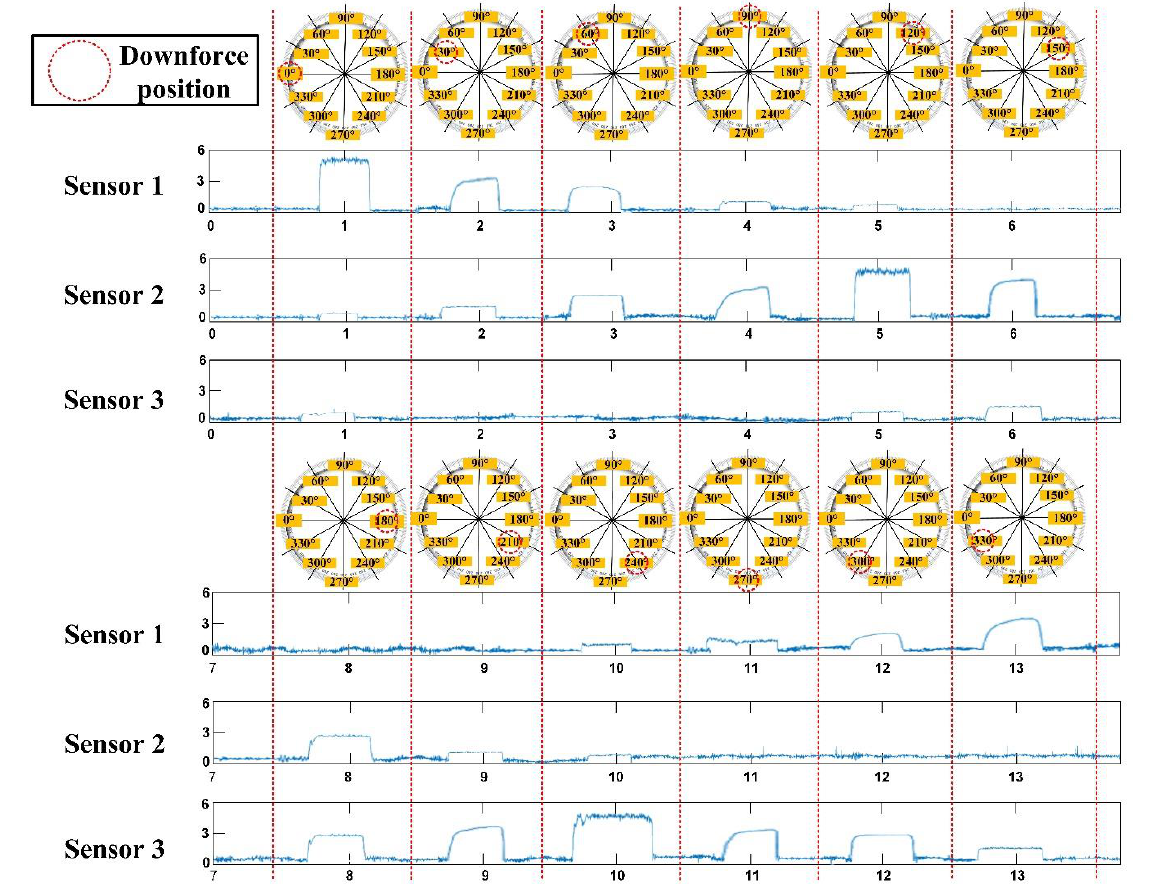
Figure 8. The different positions of the downforce angle and related force signals . Table 2. Success rate of the identification in different downforce positions .